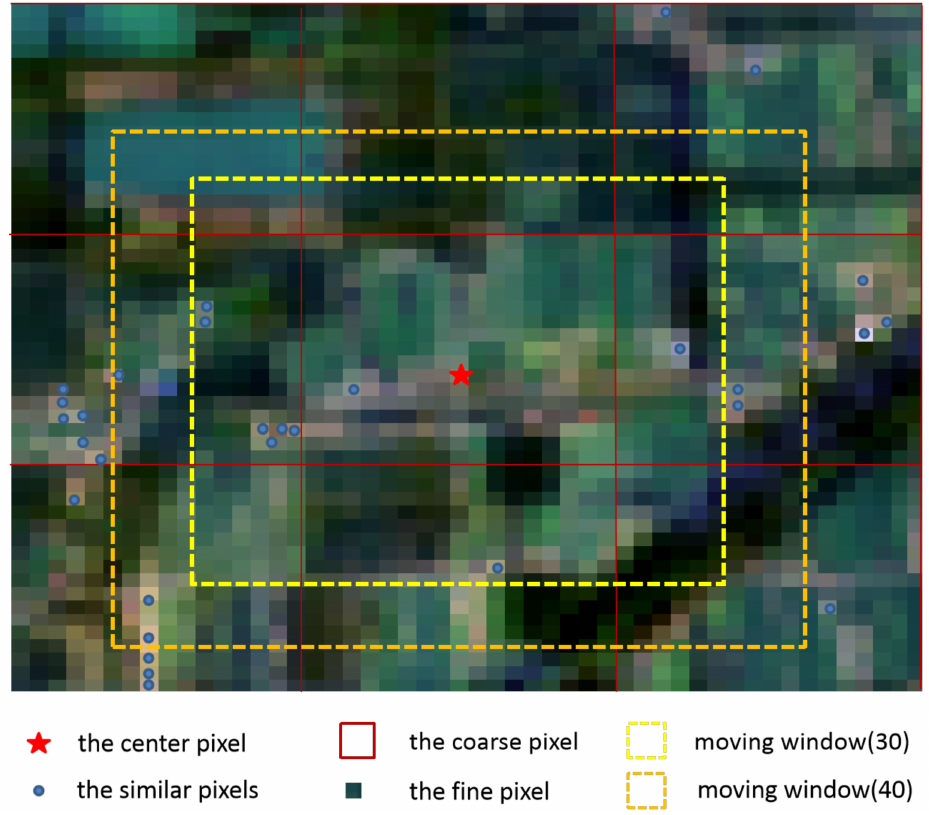
Figure 2. The schematic diagram of the adaptive moving window strategy in the spatiotemporal data fusion